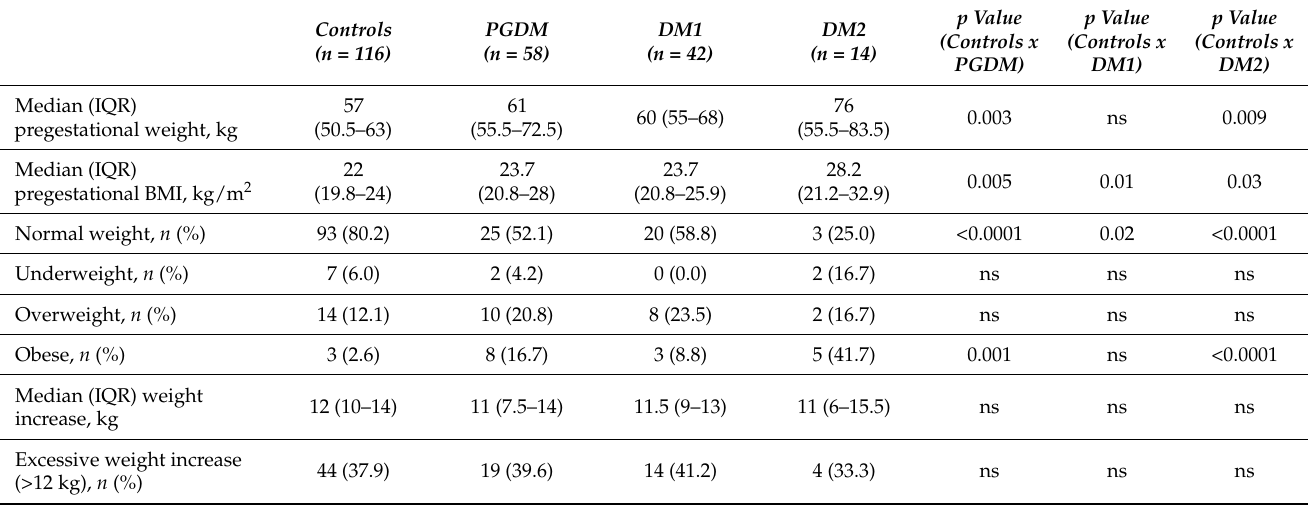
Table 1. Anthropometric characteristics of the